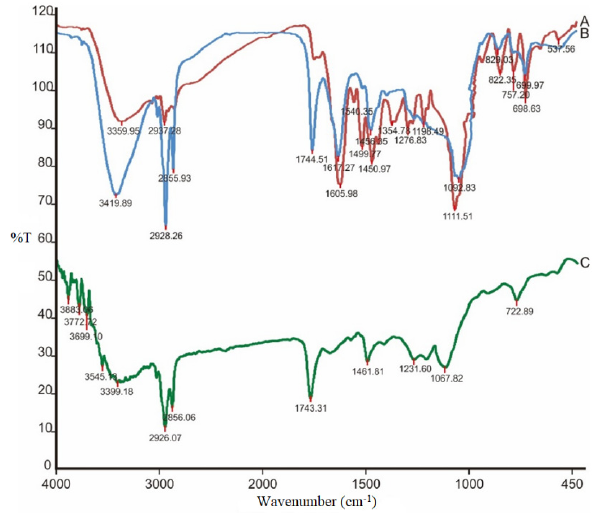
Figure 1. FTIR spectrum of D. acehensis resin E100 (A), phytosome (B), and soy lecithin (C).